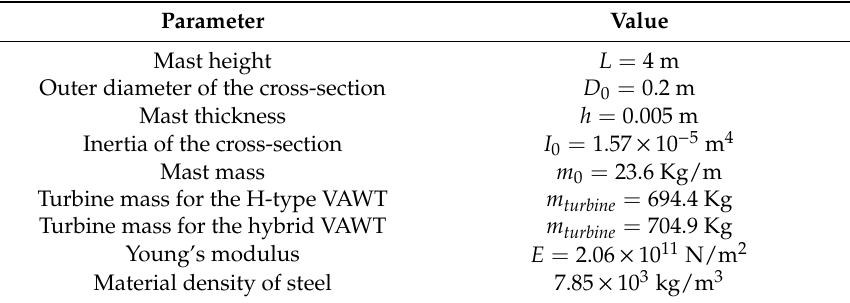
Table 3. Mast parameters of the SDOF model of the two VAWTs.